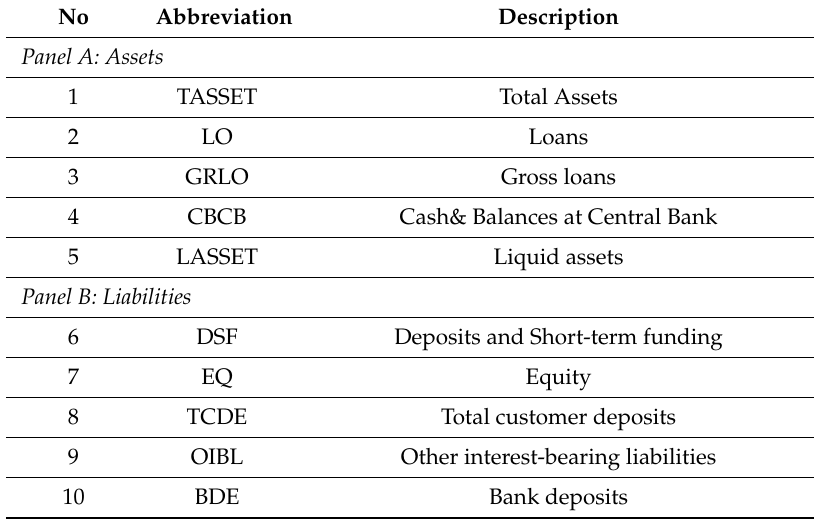
Table 1. Financial